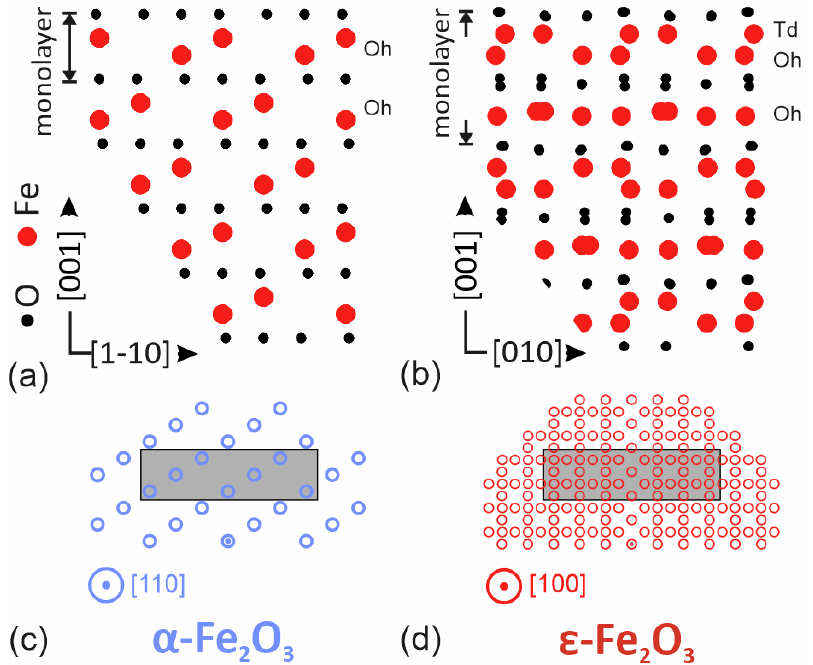
Figure 1. Crystal lattices of trigonal α -Fe 2 O 3 ( a ) and orthorhombic ε -Fe 2 O 3 ( b ). Reciprocal lattice cross-section of α -Fe 2 O 3 ( c ) and ε -Fe 2 O 3 ( d ). The reciprocal lattice nodes correspond to appearance of reflections in RHEED